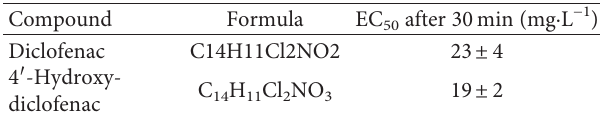
Table 3: Ecotoxicity values of diclofenac and its metabolite after 30min of exposure